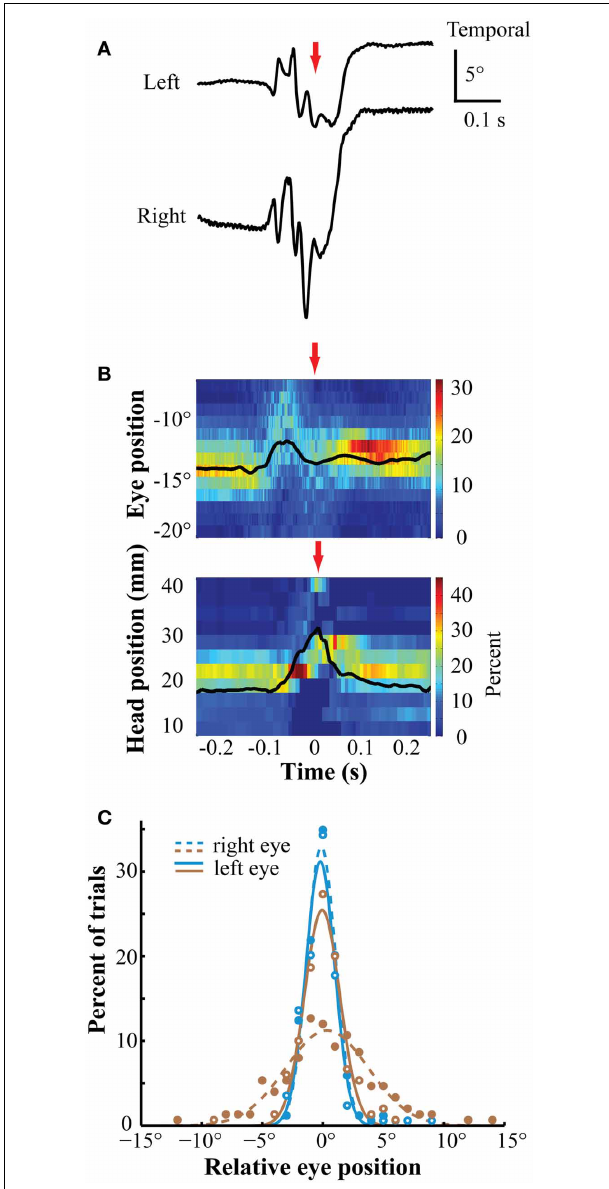
FIGURE 6 | Eye position during pecking task. (A) Representative traces of left and right eye positions before, during and after the peck. The positions are stable both before and following the peck. During the peck, the eyes briefly diverged then converged. The red arrows indicate the timing of the peck (A,B) . (B) Eye position (upper panel) and head rostrocaudal position (lower panel) were stable and stereotyped during two fixation periods, one before and one after the peck. The bin width is 1 ◦ for the eyes and 3mm for the head. The eye is in a nasal position throughout the period. Times on the abscissa are relative to the time of the peck. Colors represent percentage of trials in each position bin ( n = 188). (C) The distribution of eye positions during the post-peck fixation was highly stereotyped across eyes and sessions. These distributions are taken 155ms following the peck. Positions are relative to the median position across trials at the time of sampling in each session. Different colors represent distributions from different birds. Open markers/solid lines are from the left eye and solid markers/dashed lines are from the right